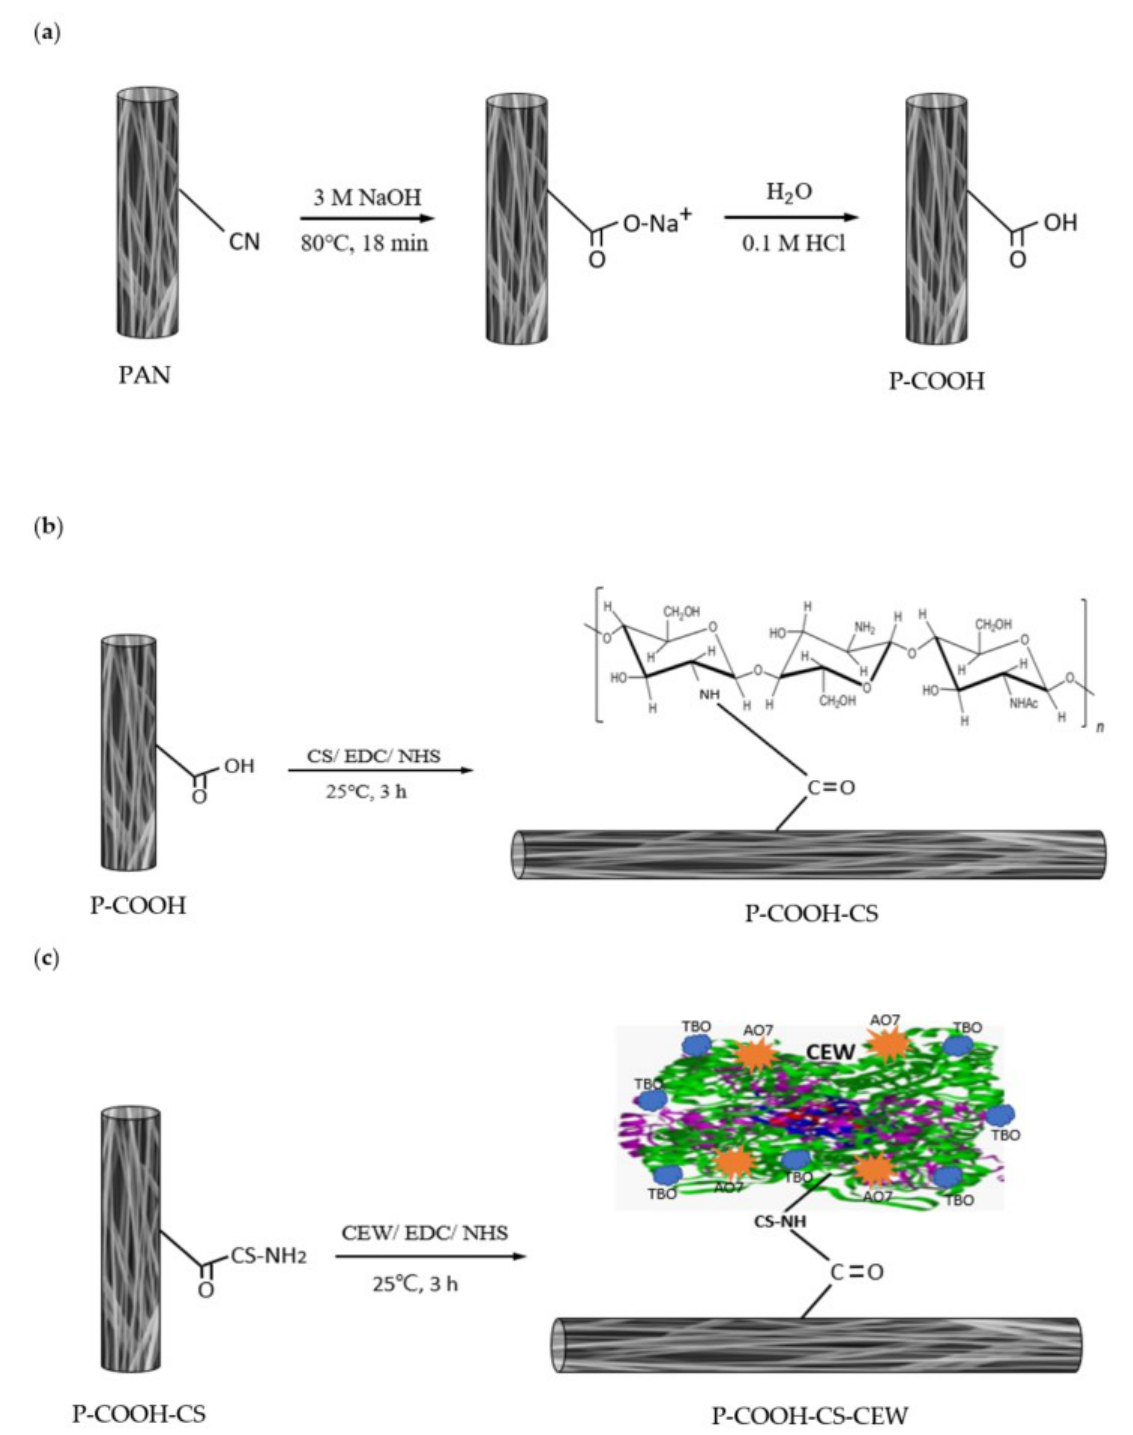
Figure 1. Preparation and modification of PAN nanofiber membranes: ( a ) P-COOH, ( b ) P-COOH-CS, and ( c )